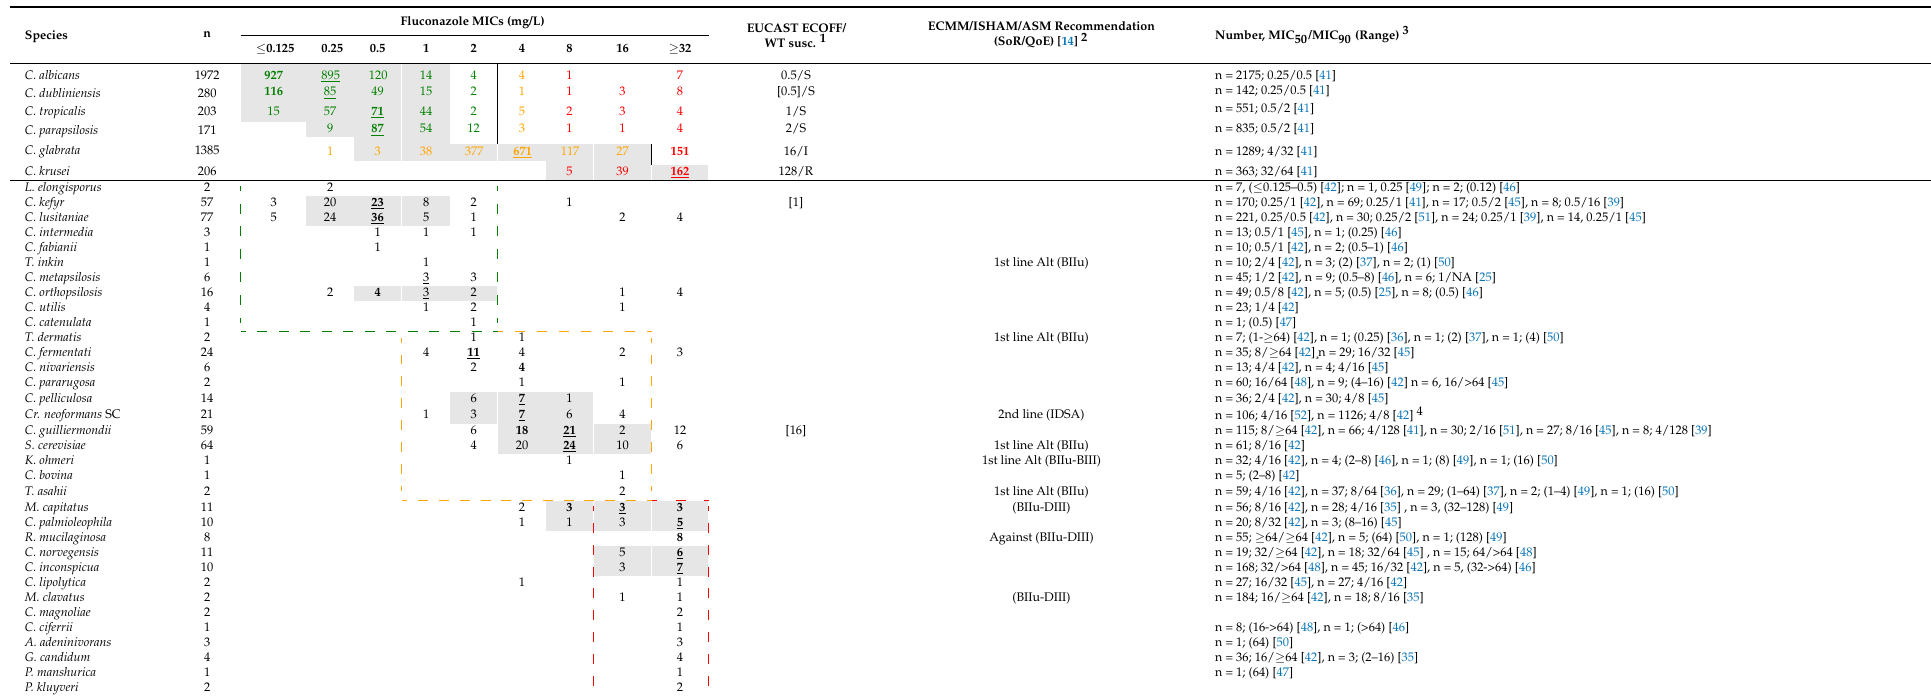
Table 6. Fluconazole EUCAST MICs against Danish common and rare yeast species sorted by increasing MICs. The coloured boxes indicate the intrinsic relative susceptibility (S (green)/I (orange)/R (red)) of wild-type isolates of a given